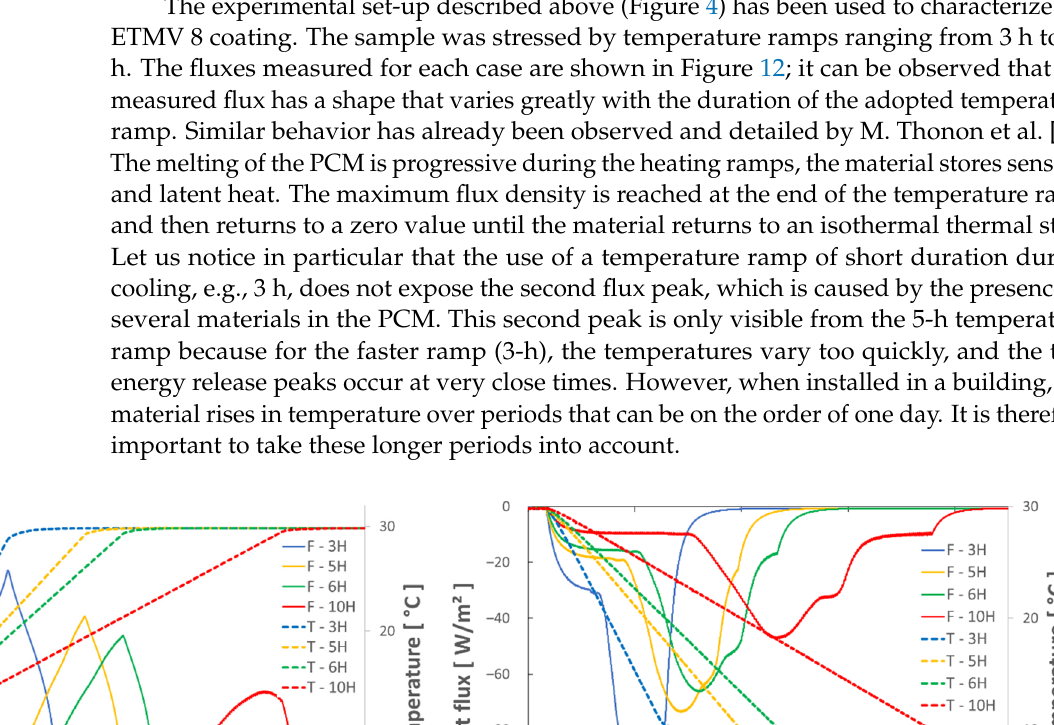
Table 4 . Thermal characteristics of ETMV 8.